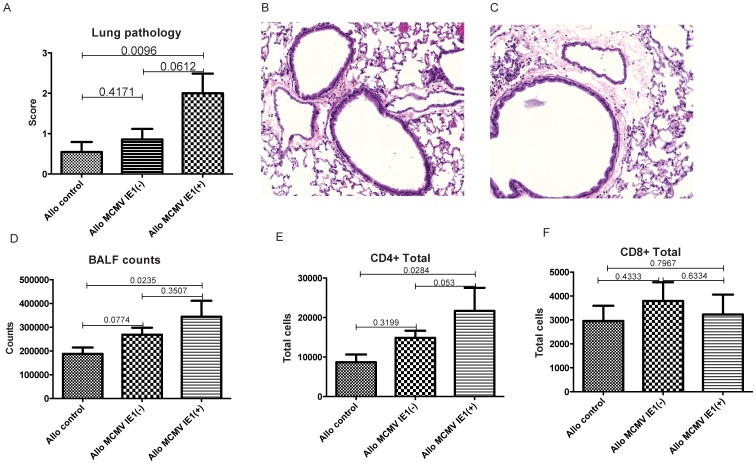
Lung injury after allogeneic HCT.Animals were transplanted as described in Materials and Methods. (A) Lung pathology was semiquantitatively assessed on day +100. Data are expressed as mean ± SEM. n = 11 (mock), 7 MCMV IE1(−) and MCMV IE1(+), respectively. (B)+(C) Example of histopathological changes (H&E stain, magnification: 200×) for (B) mock (normal lung tissue without or with minimal periluminal inflammation around airways and blood vessels, no parenchymal pneumonitis and (C) IE1(+): periluminal inflammation around airways and blood vessels but no major parenchymal pneumonitis. (D–F) Total BALF cellularity and CD4+ and CD8+ BAL T cells at day +100 after HCT.